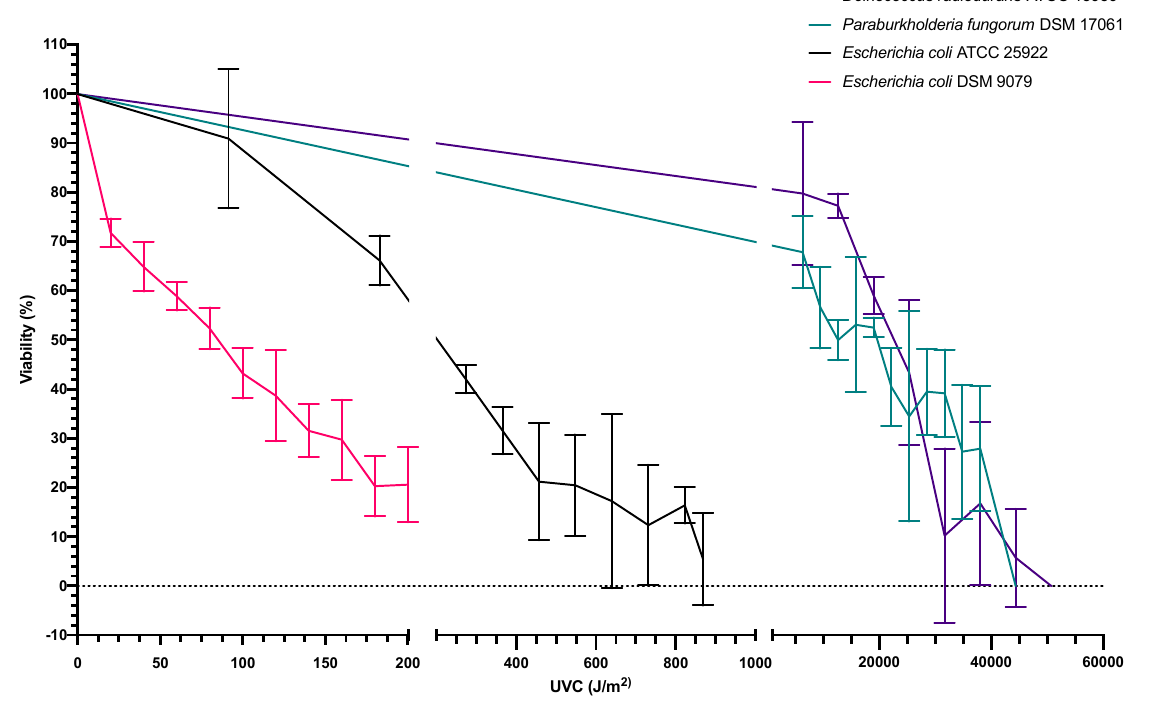
Figure 3. Percentage viability of E. coli ATCC 25922, E. coli DSM 9079, P. fungorum DSM 17061, D. radiodurans ATCC 1393 following exposure to a range of intervals of UVC doses, spanning from 0–870 J/m 2 , 0–200 J/m 2 , 0–44,415 J/m 2 and 0–50,760 J/m 2 of UVC irradiation, respectively. The error bars depict +/ − one standard deviation about the mean for each test sample.